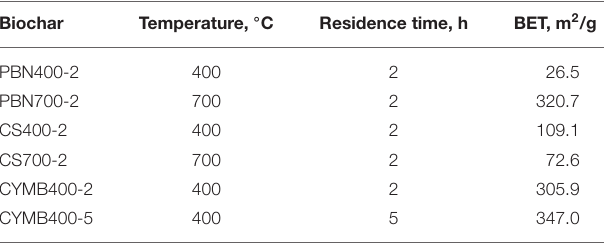
TABLE 3 | Biochar BET surface areas.